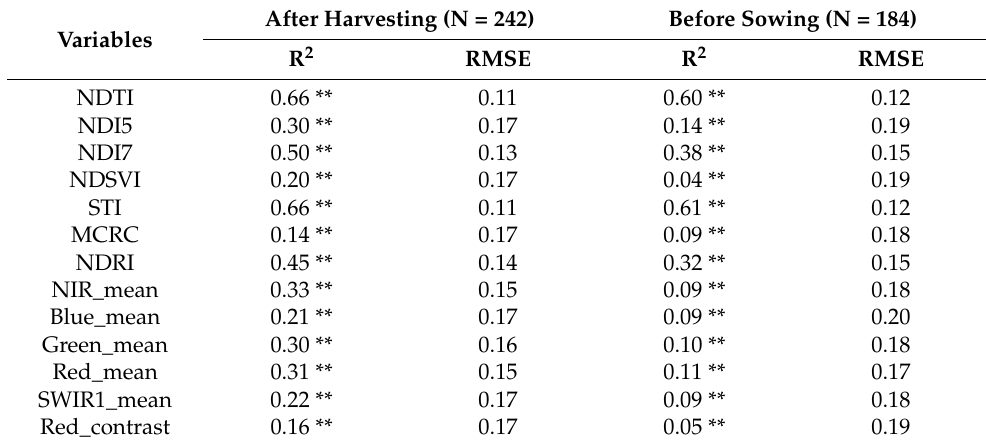
Table 4. Coefficient of determination between spectral indices and measured CRC. Figure 7. Crop type classi fi cation results in the growing season of 2020.